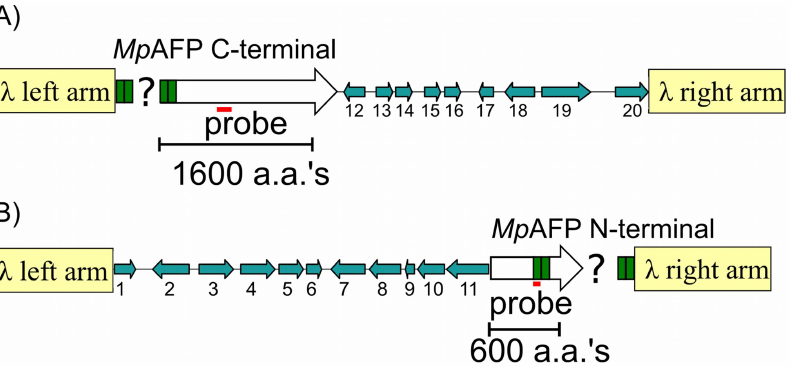
Figure 2. Lambda library clones encoding Mp AFP. (A) Schematic layout of the lambda clone containing DNA coding for the C-terminal portion of Mp AFP and nine downstream genes, 12–20. The flanking genes (blue arrows) are identified by their numbers in Table S2. The arrows point in the direction of transcription. The left and right arms of lambda phage (not to scale) are indicted by the tan-colored rectangles. Green boxes represent the tandem, identical 312-bp repeats of Mp AFP. The question mark represents the unknown number of these repeats present within the clone. The location of the initial hybridization probe is indicated by the horizontal red line. The scale is indicated by the bracket representing DNA coding for 1600 amino acids (aa’s). (B) Schematic layout of a second lambda clone that contains DNA coding for the N-terminal portion of Mp AFP and eleven upstream genes (1–11). Symbols are as described in (A), with the bracket representing DNA coding for 600 amino acids and the red bar indicates the location of the second hybridization